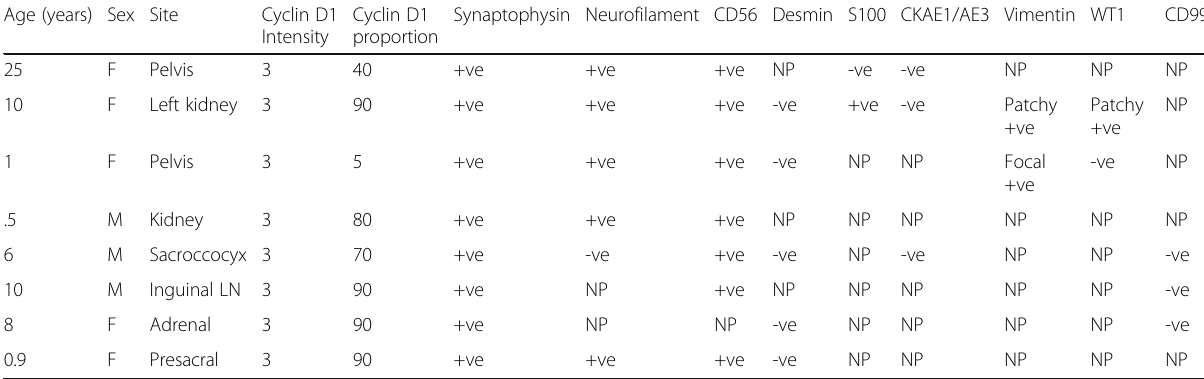
Table 3 Clinical details and results of immunohistochemical staining with Cyclin D1 and other IHC markers in neuroblastoma ( n =